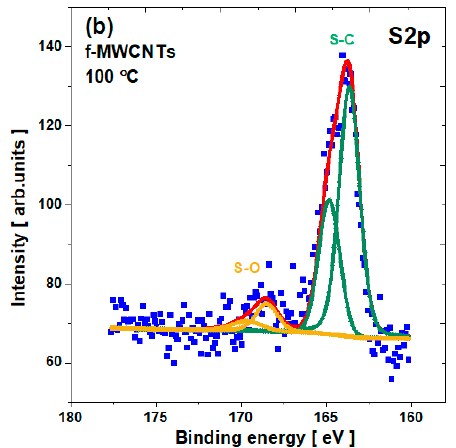
Figure 7. The O1s core level line for f-MWCNTs: ( a ) pristine; ( b ) calcined at 100 °C; ( c ) calcined at 200 °C; and ( d ) calcined at 300 °C.